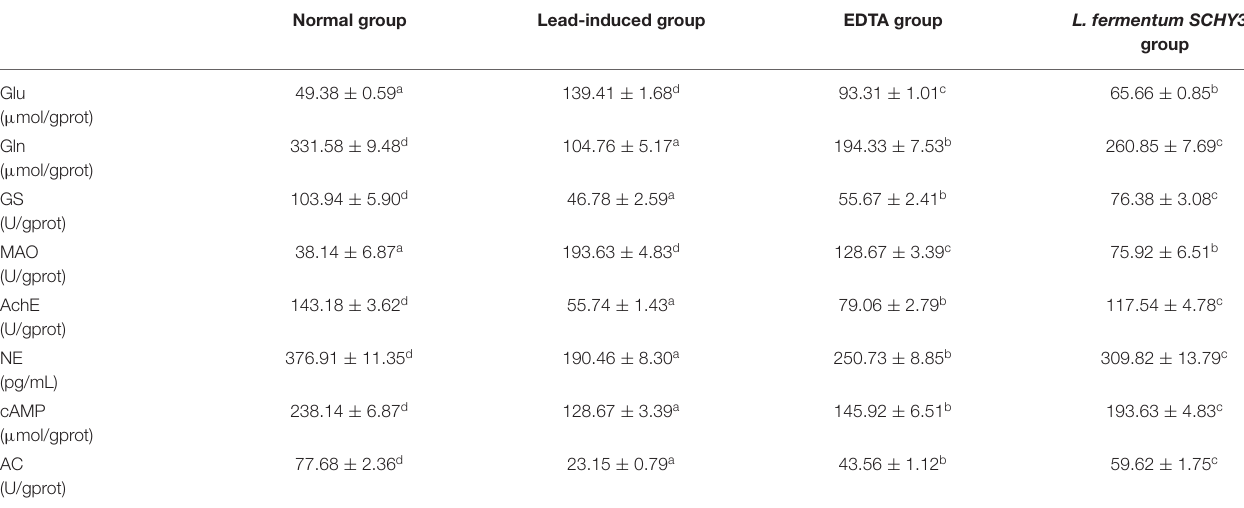
TABLE 7 | Glu, Gln, GS, MAO, AchE, NE, cAMP, AC in the brain tissue of SD rats.